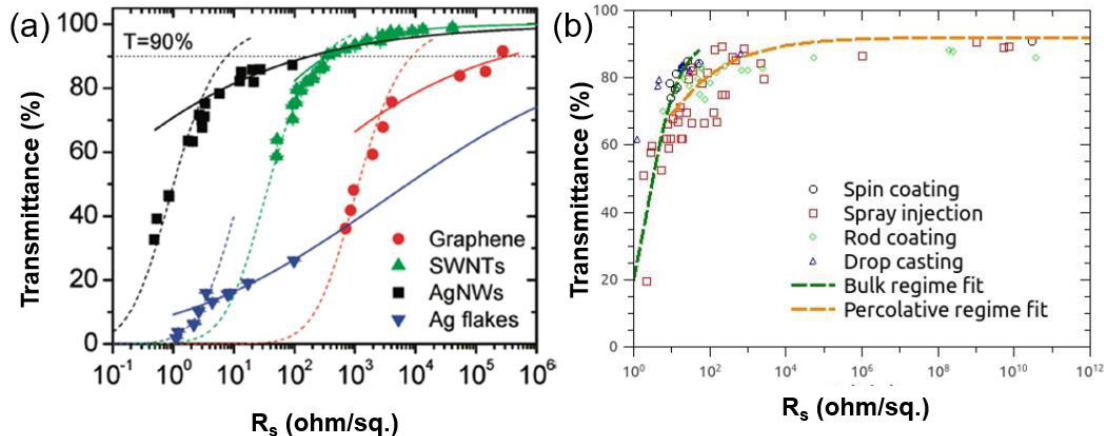
Figure 10. ( a ) Optical transmittance of Ag NWs vs. sheet resistance for various thin films of graphene, single-walled CNTs, Ag NWs, and silver flakes (dashed lines: bulk regime, solid lines: percolative regime). Reproduced with permission from [33]. Copyright 2010 American Chemical Society. ( b )